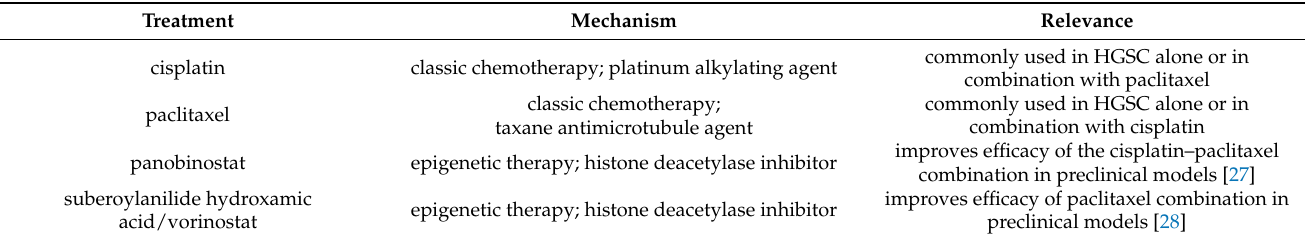
Table 1. Drug treatments used as well as their respective mechanisms of action and clinical relevance. Treatment Mechanism